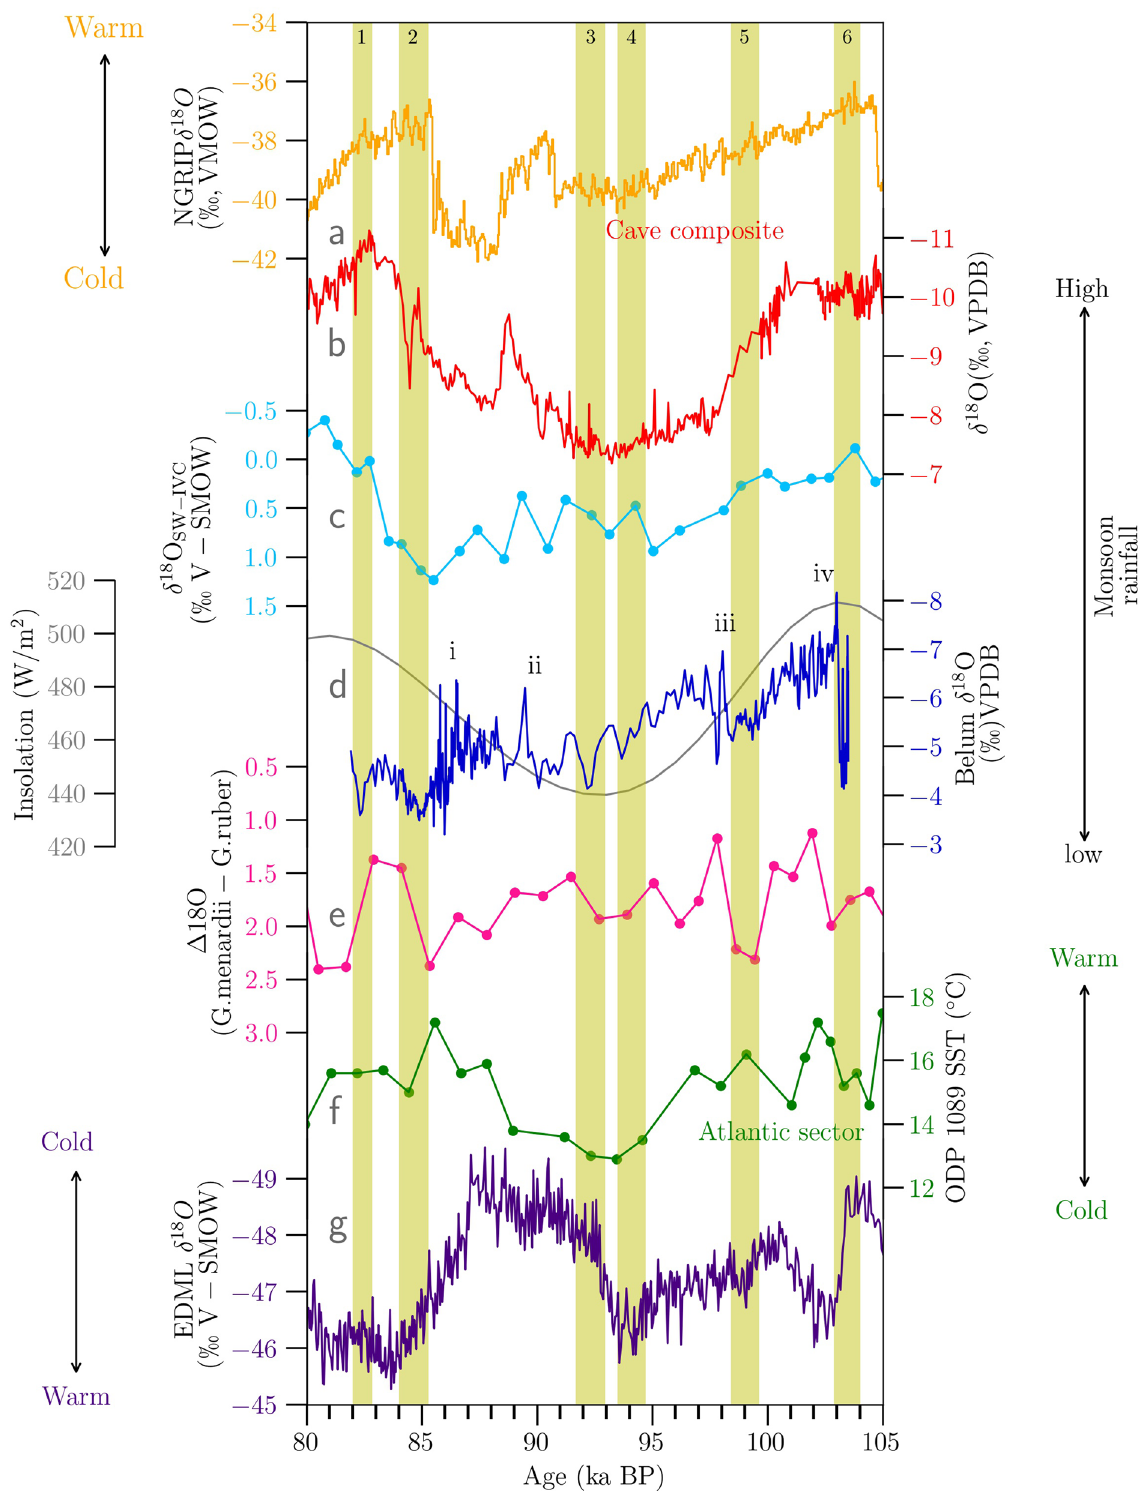
Figure 3. ( a ) NGRIP ice core δ 18 O record 48 ( b ) Cave composite δ 18 O record based on Chinese speleothems 24 ( c ) ice volume corrected δ 18 O sw-ivc record from site SO-188-17,286-1 49 , northern Bay of Bengal ( d ) Belum Cave δ 18 O record (Present study) and insolation at 30° N (dark grey) ( e ) difference between δ 18 O of surface ( G.ruber ) and thermocline dwelling ( G.menardii ) foraminifera from tropical Southern Hemisphere (core BP13/A) 50 . ( f ) Radiolarian based SST reconstruction from the core site ODP 1089 northern subantarctic in Atlantic sector 51 . ( f ) EDML δ 18 O record 52 . The shaded yellow areas numbered 1–6 represent episodes of weaker monsoon observed in our record and i-iv correspond to strong monsoon events. The locations of the core sites are shown in SI Fig.